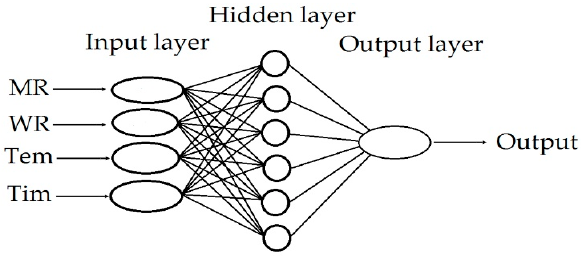
Figure 1. The schematic structure of the ANN-MLP algorithm used.